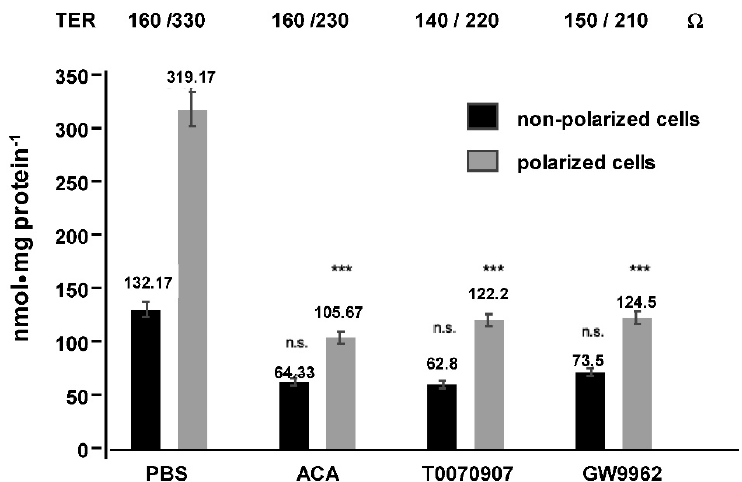
peroxisome proliferator-activated receptor γ (PPAR γ ) inhibitors T0070907 or GW9962 (Figure 8).